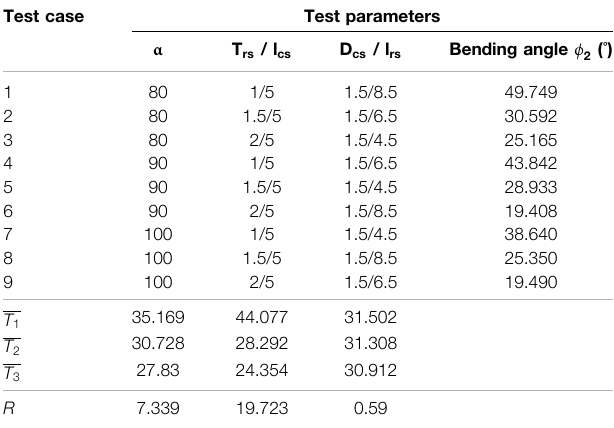
TABLE 3 | Orthogonal experiment of structural parameters in a pantographic